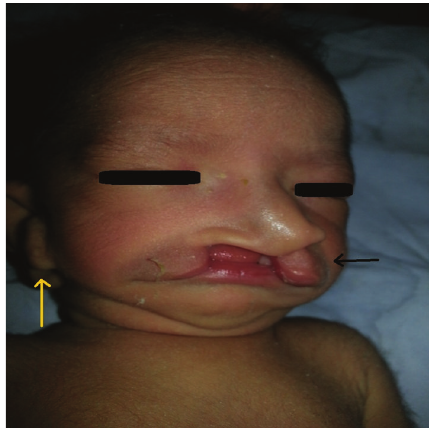
Figure 3: Presenting the right cleft lip, hypertelorism, and microg-